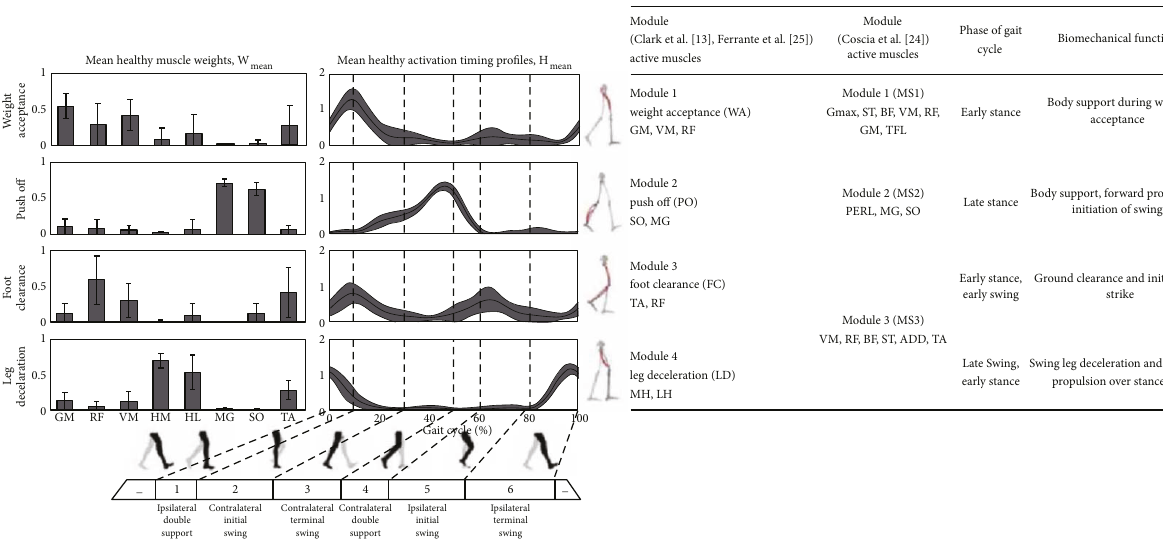
Figure 3: Comparison of healthy modules across included studies. Common modules found during normal steady state walking as described for comparison by Clark et al. [14], Ferrante et al. [28], and Coscia et al. [27]. For each module, the primary muscle activity which composes the module is listed as well as the corresponding phase of gait and biomechanical function. The image reproduced from Ferrante et al. [28] demonstrates the muscle weightings and timing for each module and highlights the phase of the gait cycle where each module is used. Key coactive muscles in each module are highlighted red on the lower body illustration. TA: tibialis anterior; SO: soleus; MG: medial gastrocnemius; VM: vastus medialis; RF: rectus femoris; MH: medial hamstrings; LH or HL: lateral hamstrings; GM: gluteus